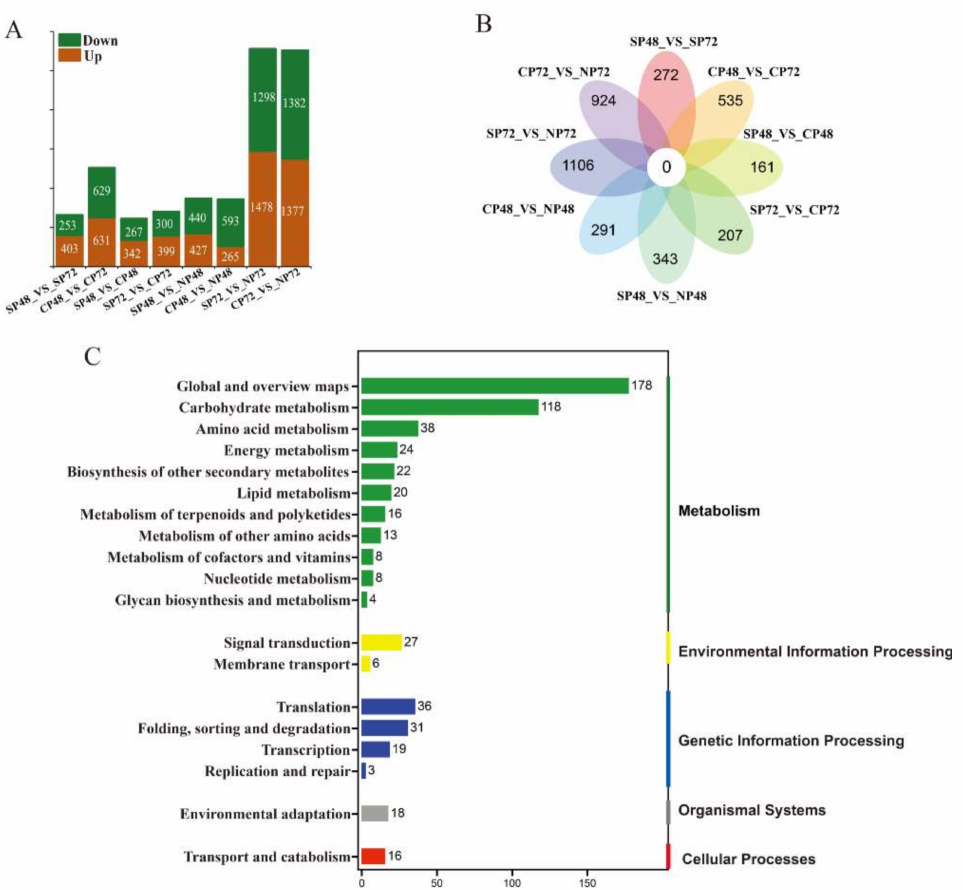
Figure 3. Analysis of di ff erentially expressed transcripts (DETs) in self-, cross- and non-pollinated pistils of Camellia oleifera . ( A ) Numbers of DETs in the 8 pairs of self-, cross- and non-pollinated pistils. ( B ) Venn-flower diagram of DETs in the 8 pairs of self-, cross- and non-pollinated pistils. ( C ) KEGG pathway annotation of DETs in self- and cross-pollinated pistils. SP48 / 72, self-pollinated pistils at 48 h / 72 h; CP48 / 72, cross-pollinated pistils at 48 h / 72 h and NP48 / 72, non-pollinated pistils at 48 h / 72